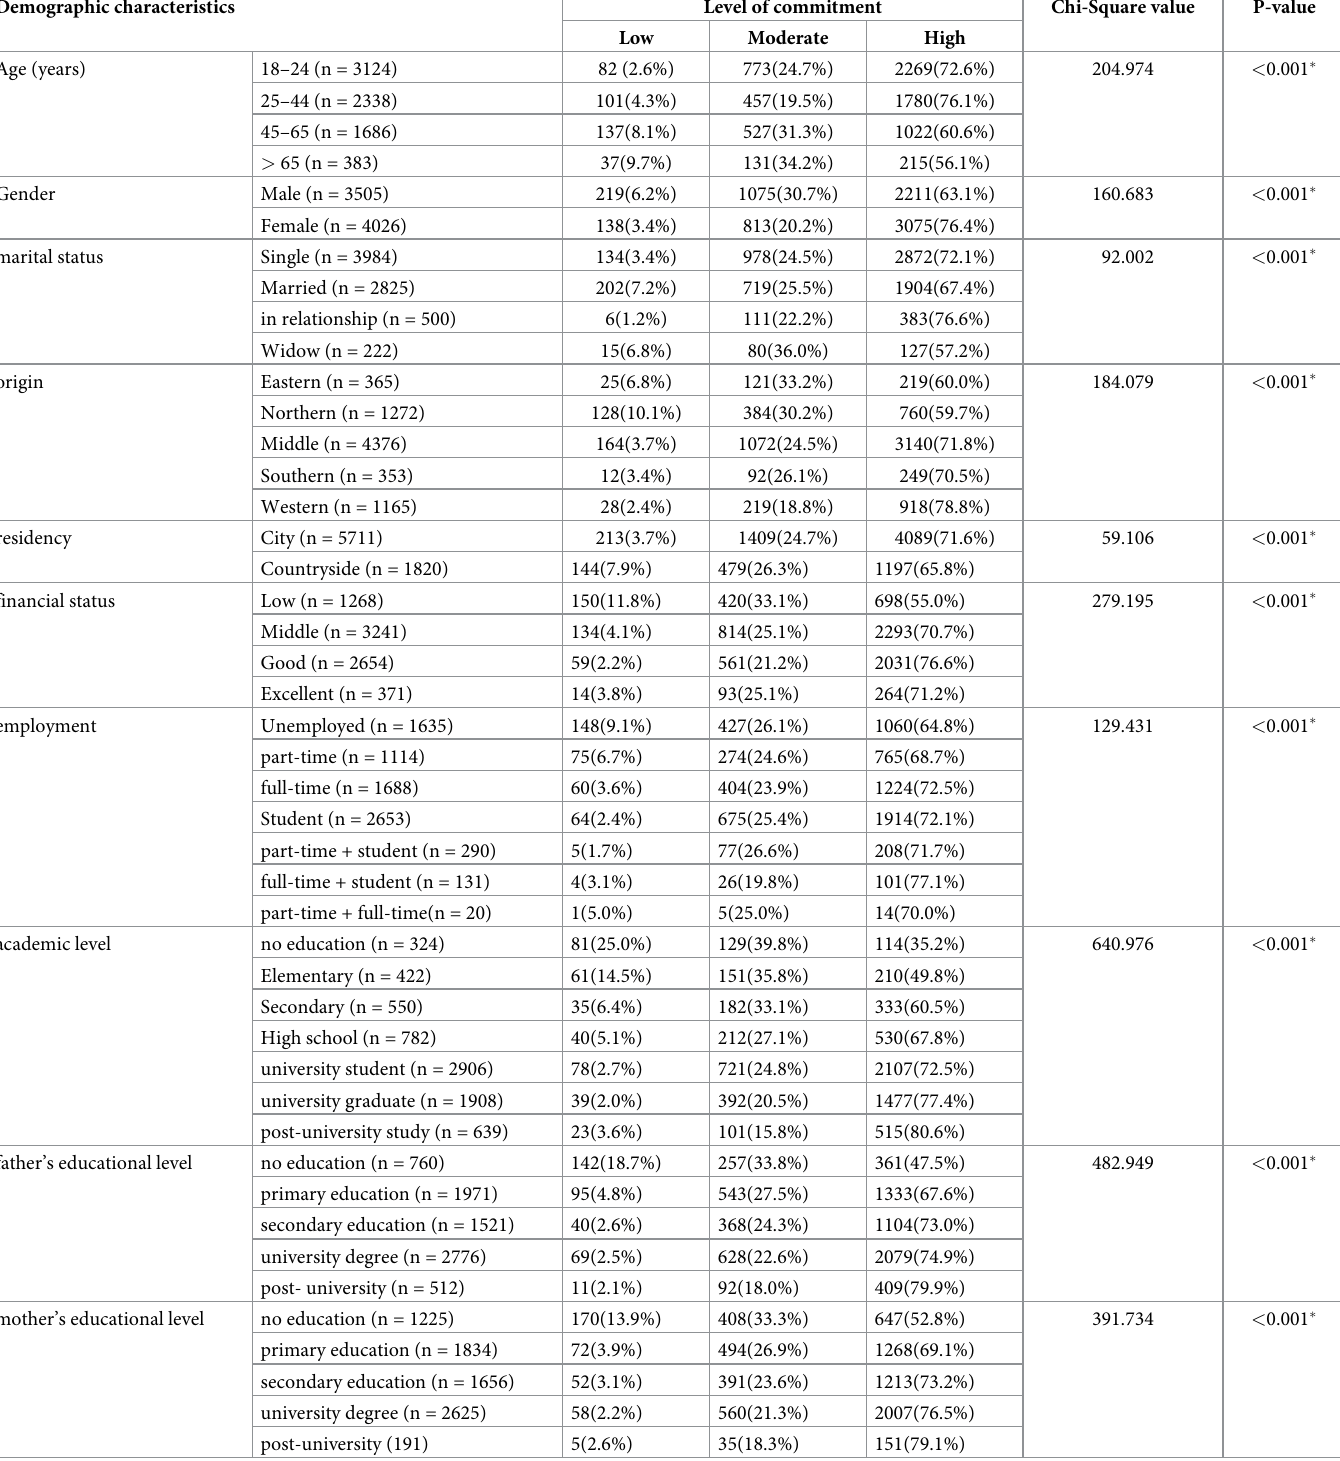
Table 5. Correlation between demographic characteristics and level of commitment to protective measures. Demographic